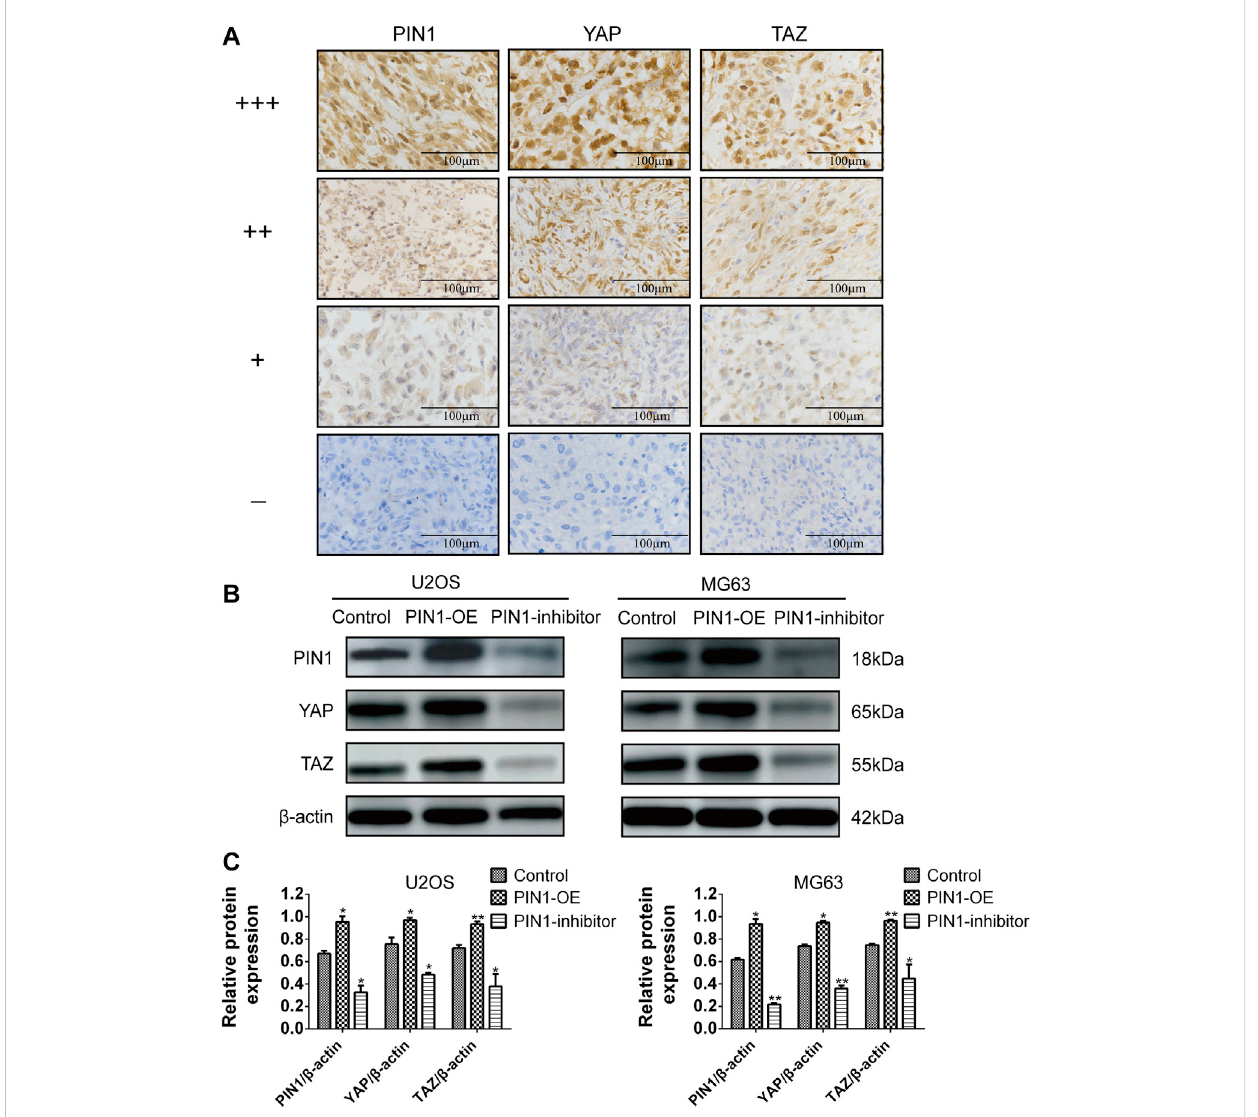
The correlation of PIN1, YAP and TAZ. (A) Immunohistochemical results scoring criteria. (B) The expression levels of PIN1, YAP, and TAZ were detectedbywesternboltafterPIN1-OE(pcmv-HA-PIN1)andPIN1inhibitor(juglone).Scalebarstandsfor100 μ m. (C) Quanti fi cationofwesternblotdata from (B) . Results were presented as the mean ± SEM of three independent experiments. * p < 0.05, ** p < 0.01 vs . control group (one-way ANOVA).